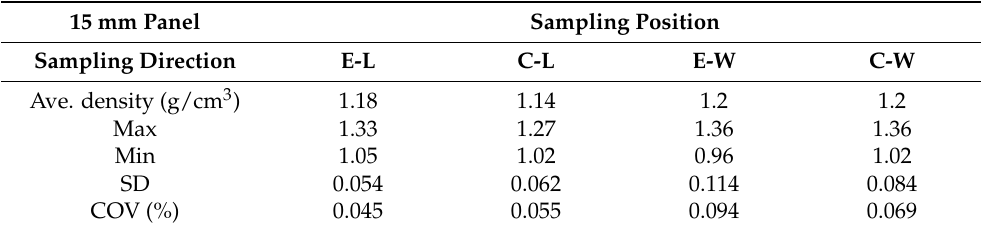
Table 4. Location effects on density and its variability for a 15-mm panel using 50 × 50-mm 2